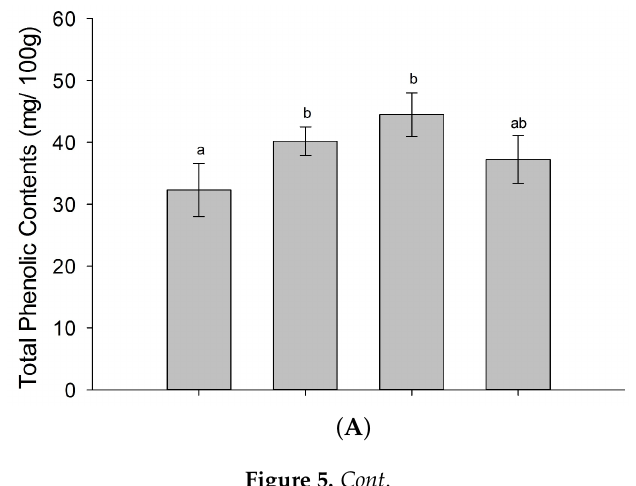
( A ) Figure 5. Cont